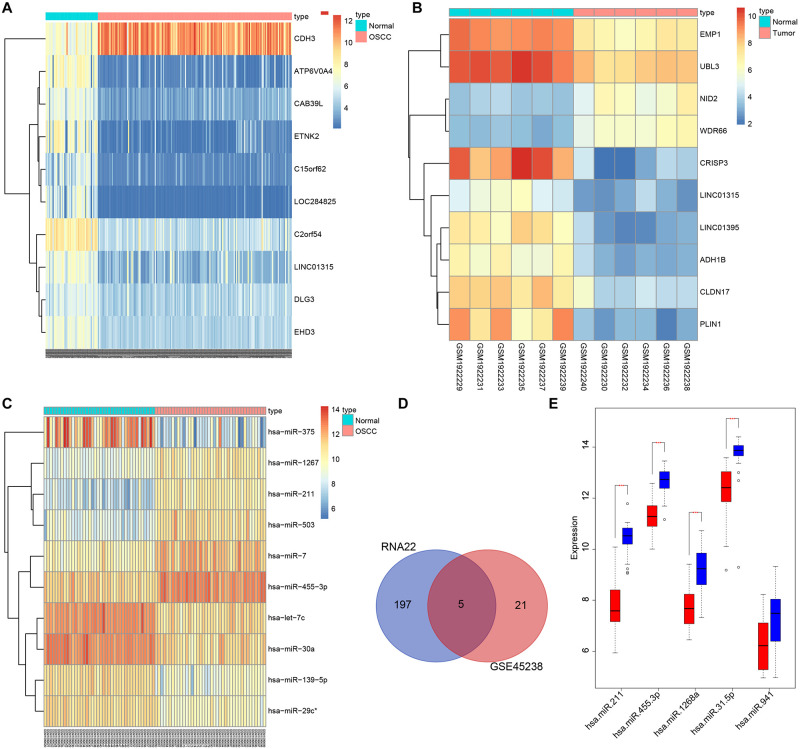
LINC01315 may modulate miR-211-mediated DLG3 expression to participate in OSCC process. (A) Expression heatmap of LINC01315 in the OSCC-related expression dataset GSE30784; (B) Expression heatmap of LINC01315 in the OSCC-related expression dataset GSE74530; (C) A heatmap of differentially expressed miRNAs in the OSCC-related expression dataset GSE45238; the X axis denotes the samples, and the Y axis denotes the genes. The upper right histogram represents the color scale, where the change of color from top to bottom indicates that the expression value in the expression datasets varies in descending order. Each square depicts the expression of a gene in the corresponding sample, and each column denotes the expression of all genes in each sample. The left dendrogram denotes the clustering results among genes from different samples. The top bar denotes the sample type. The upper right box implies the level of expression, the color red indicates tumor samples, and the color blue indicates normal control samples; (D) Two circles respectively represent the downstream miRNAs of LINC01315 predicted using the RNA22 database and the upregulated miRNAs in the expression dataset GSE45238 and the middle part indicates the intersection miRNAs from two circles; (E) Expression of the miRNA candidates obtained from panel D in OSCC and normal samples in expression dataset GSE45238; the X axis refers to the miRNAs, the Y axis refers to the expression, the red box plot refers to normal samples and the blue box plot refers to OSCC samples (***p < 0.001).